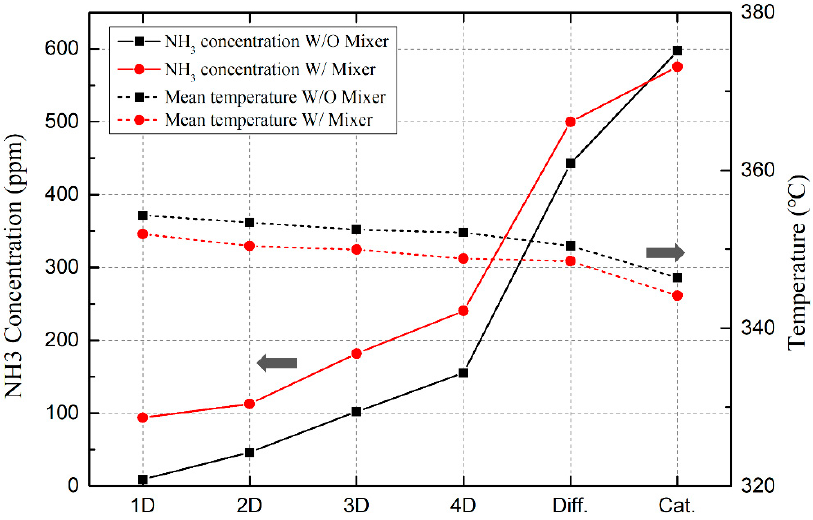
Figure 6. Mean temperature and NH 3 concentration at specific positions with and without mixer.